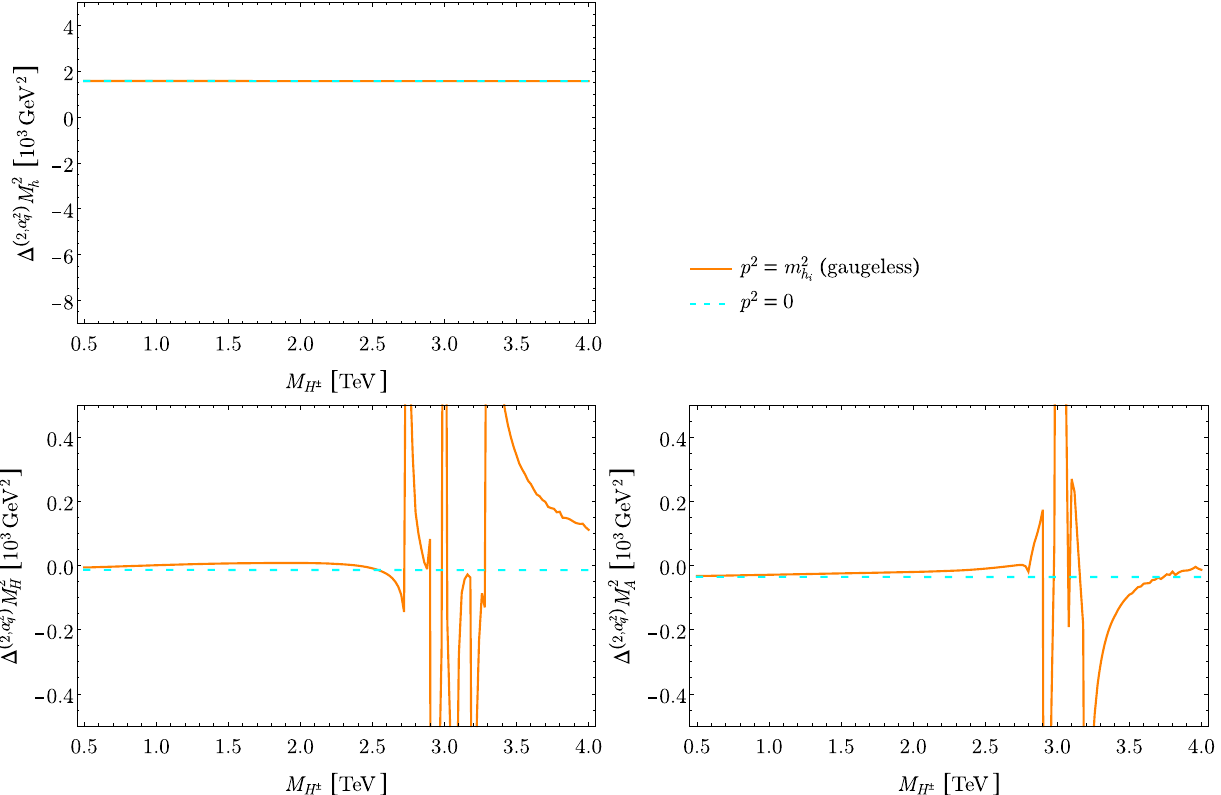
(cid:2) (cid:3) α 2 for the neutral Higgs states. The color-code follows the conventions of Fig.2. The wiggly lines at M 2 q